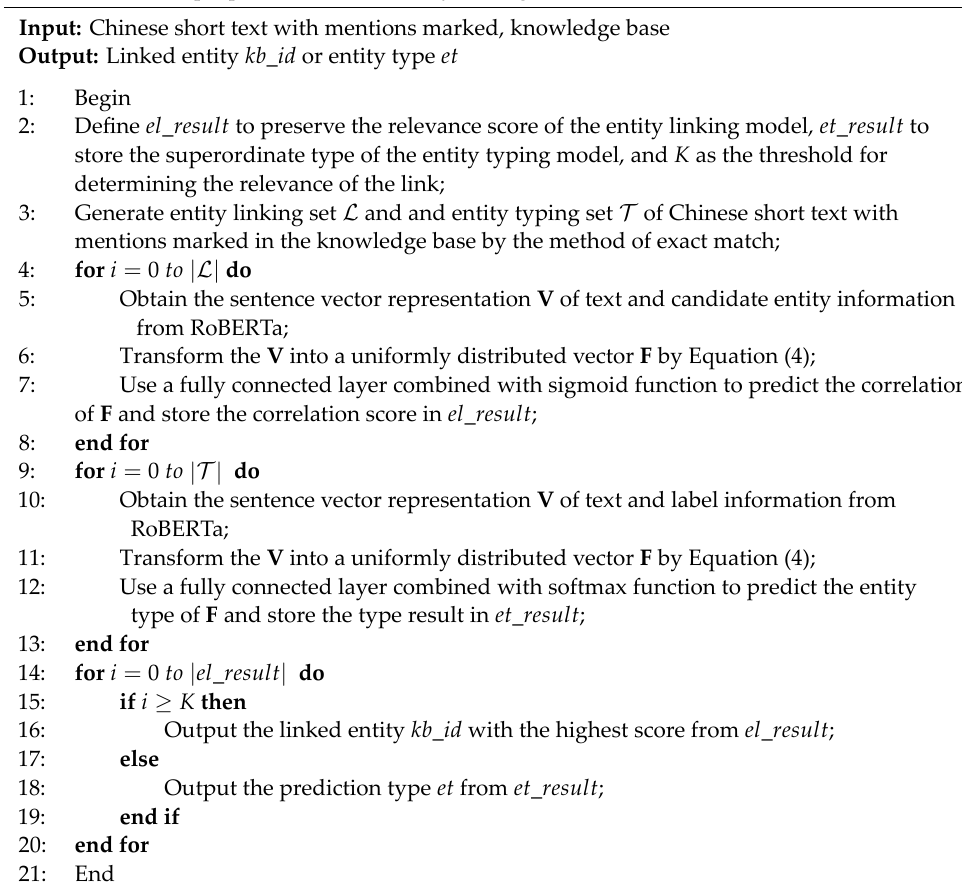
Algorithm 1 Our proposed model for entity linking of Chinese short